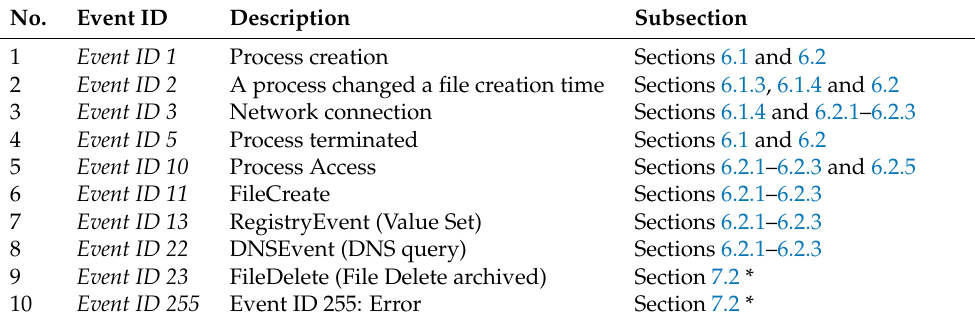
Table 3. Sysmon-generated events during the conducted experiments of Sections 6.1 and 6.2. The star exhibitor denotes normal traffic